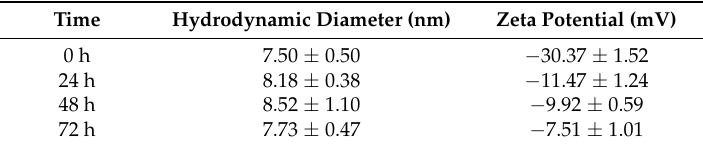
Table 1. The hydrodynamic size and zeta potential of dextran-coated Fe 2 O 3 nanoparticles measured at various time points. The results were expressed as mean values ± SD ( n =